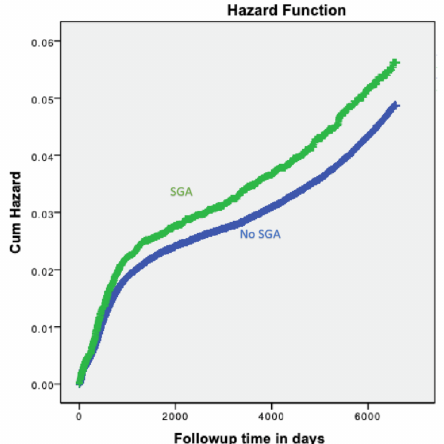
Figure 1. Kaplan–Meier survival curve demonstrating the cumulative incidence of total hospitalizations with neurological morbidities in SGA vs. non-SGA neonates (log-rank p < 0.001).